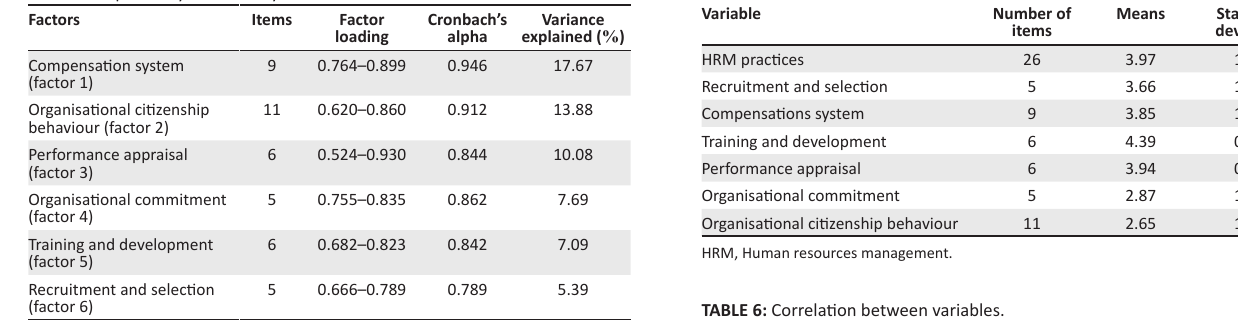
TABLE 5: Mean scores of the study variables.